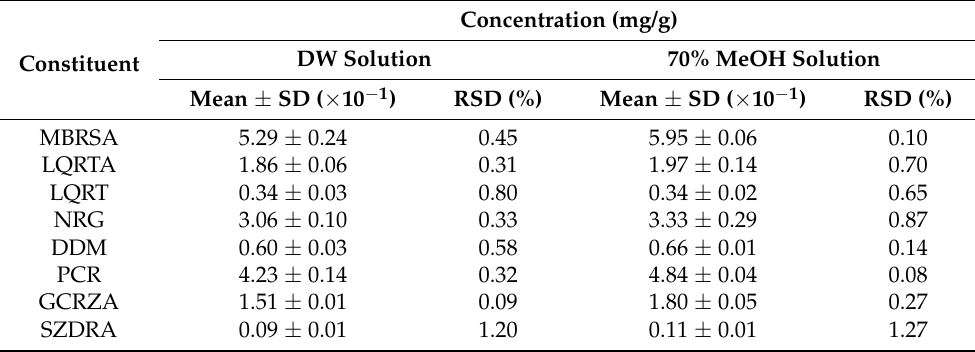
Table 4. Concentrations of eight representative marker constituents in ISYPT samples by